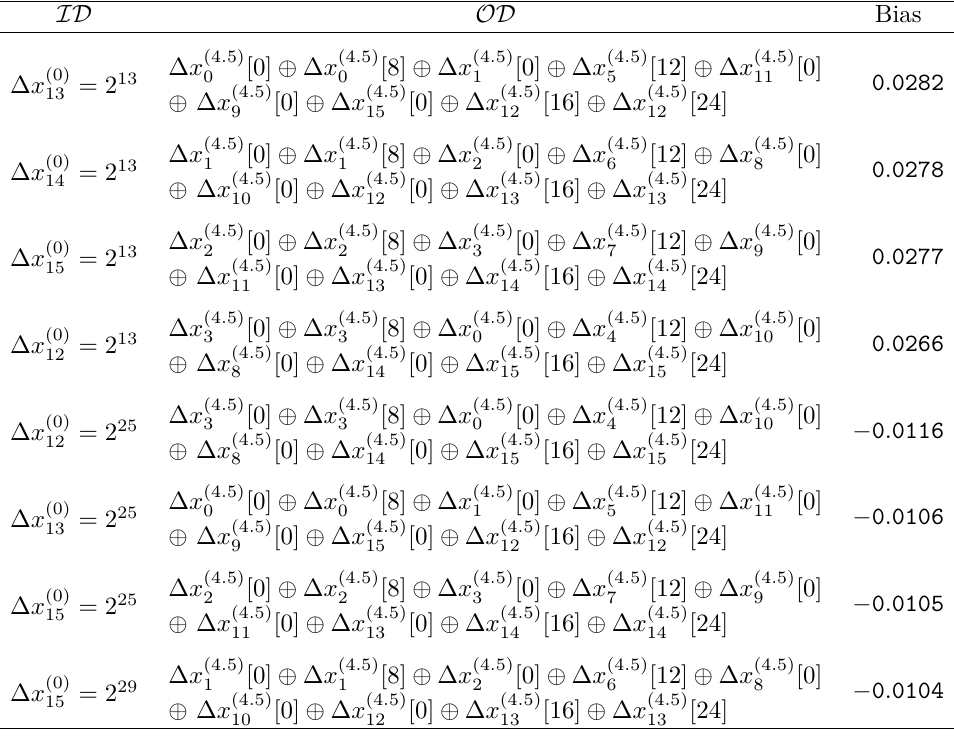
Table 10: Best multi-bit differentials for 4.5 rounds of